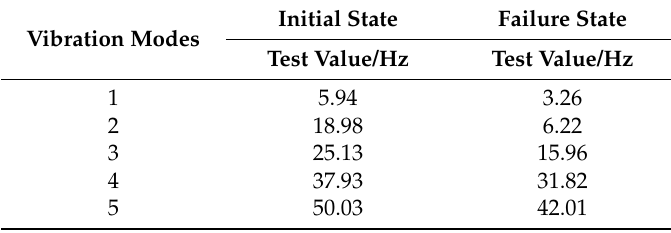
Figure 6. Test results: ( a ) The hysteretic curve and ( b ) lateral displacement. Table 3. Test value of